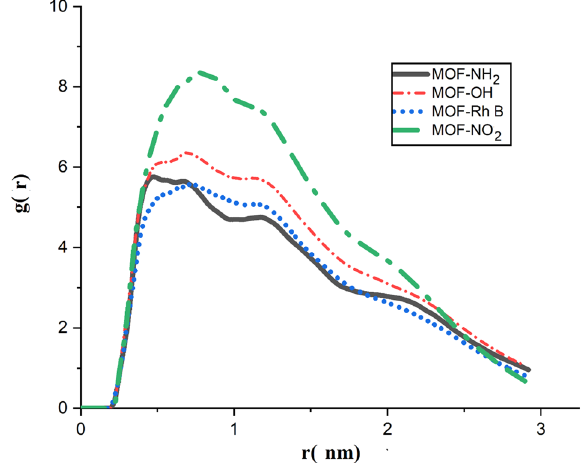
Fig. 3 The RDF of Rh B molecules with respect to the MOF (blue), MOF-NH2 (black), MOF-OH (red), and MOFNO2